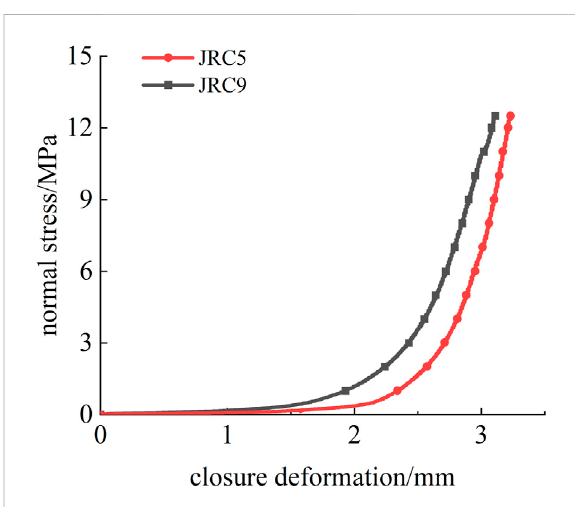
FIGURE 9 Normal stress-closure deformation curve of a fi lled rock joint under the same fi lling